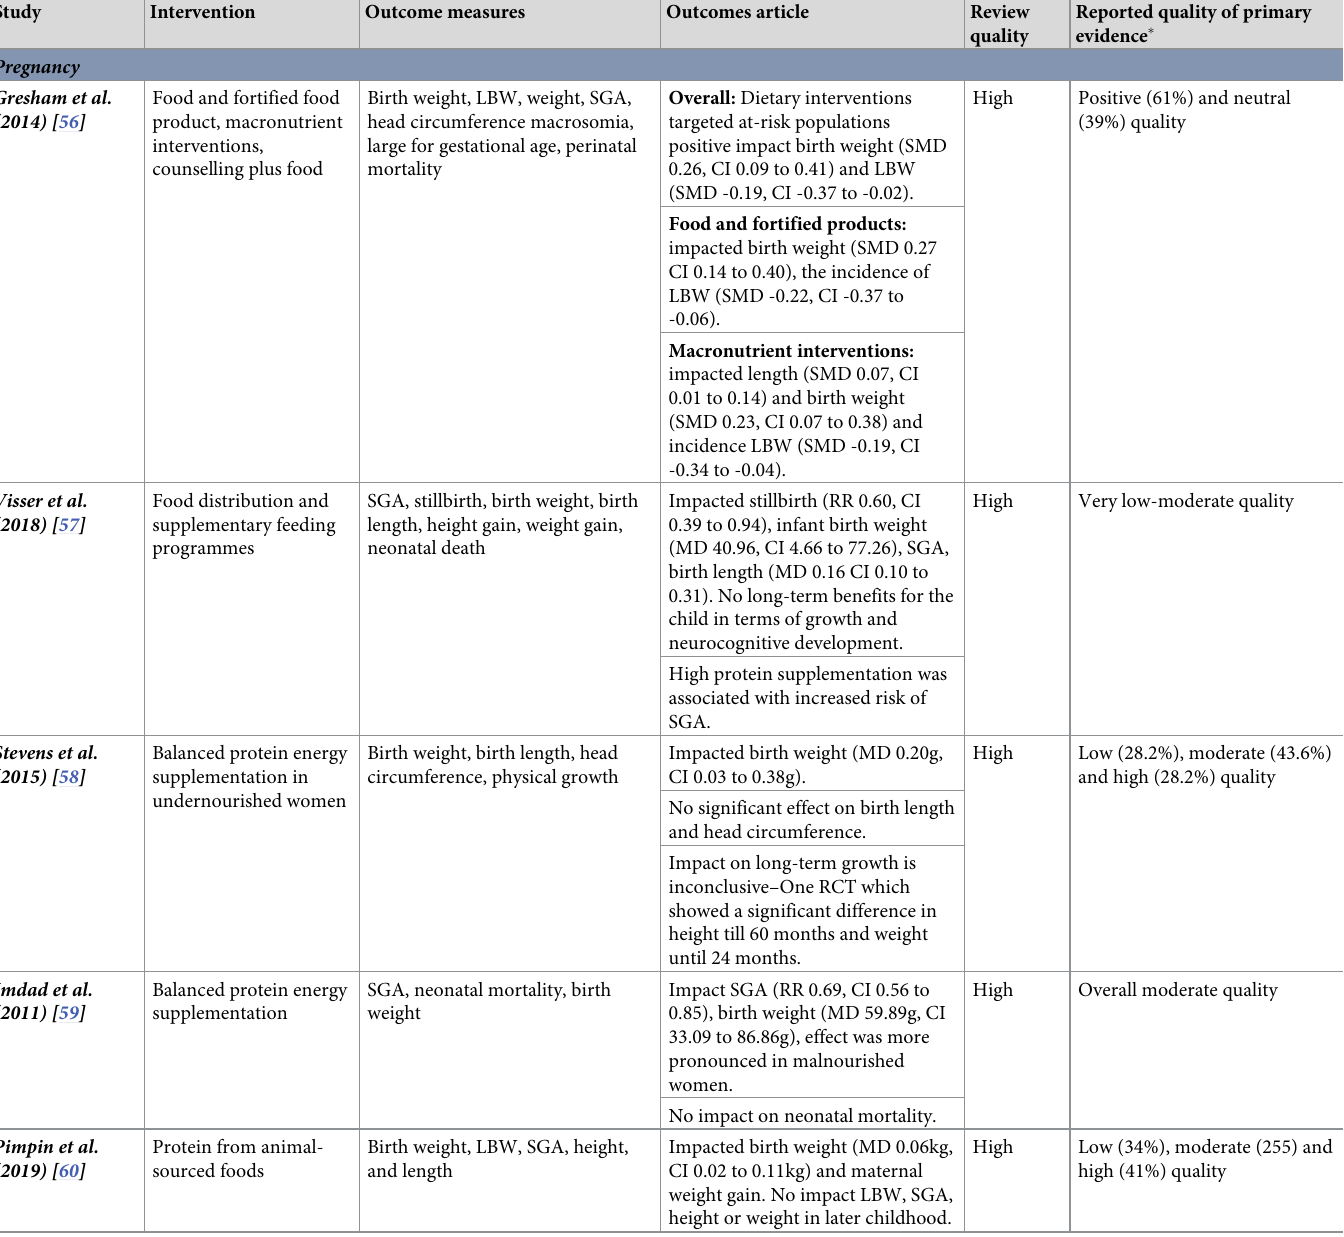
Table 2. Summary of maternal supplementation interventions, during lactation and